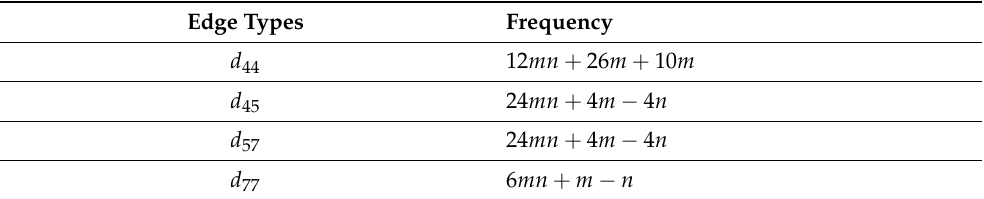
Table 12. Partition Table for β